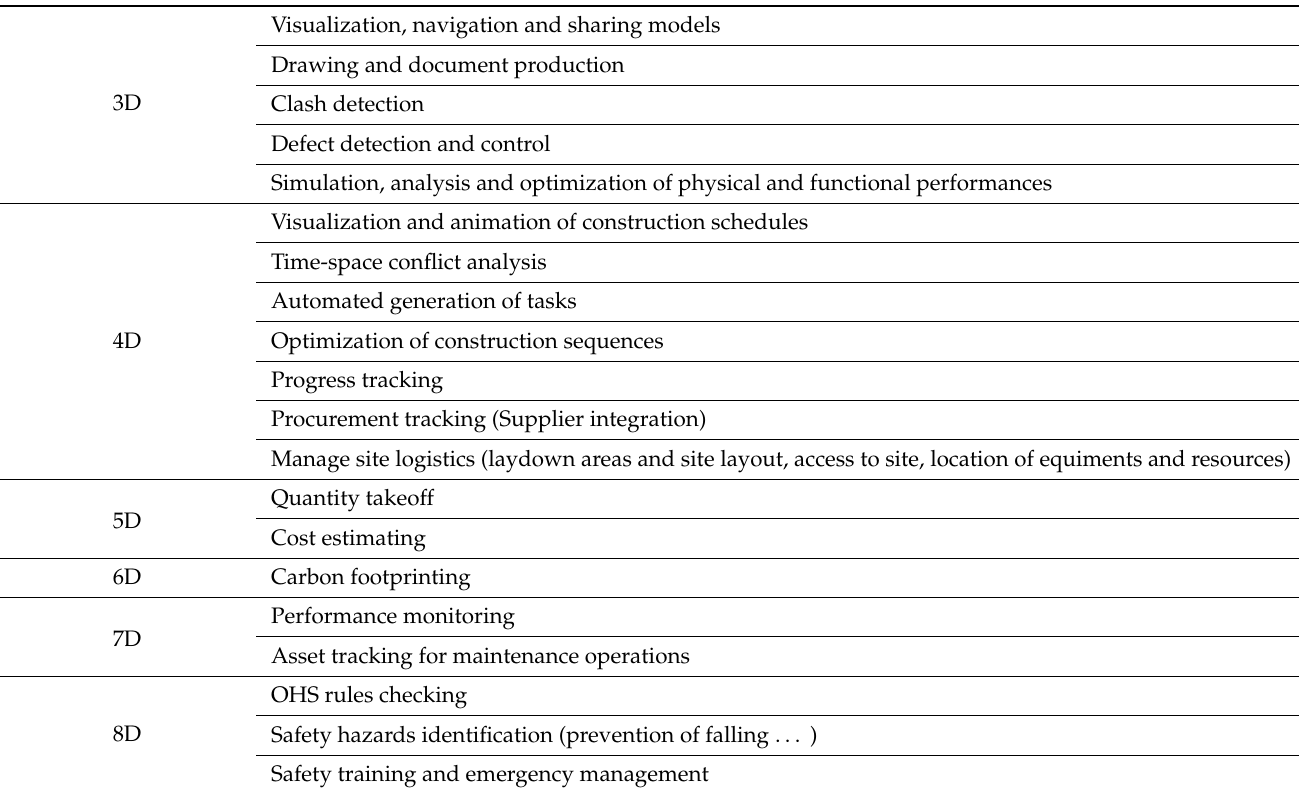
Table 1. Main applications of BIM dimensions and